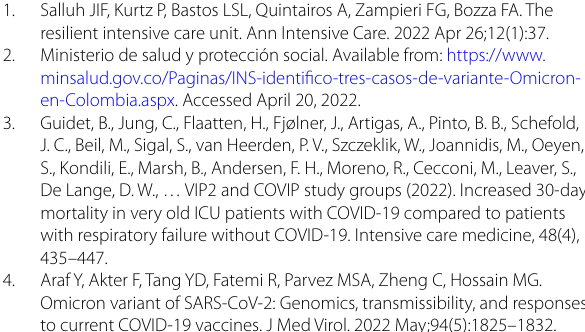
Conclusion: COVID-19 was not associated with the development or the severity of